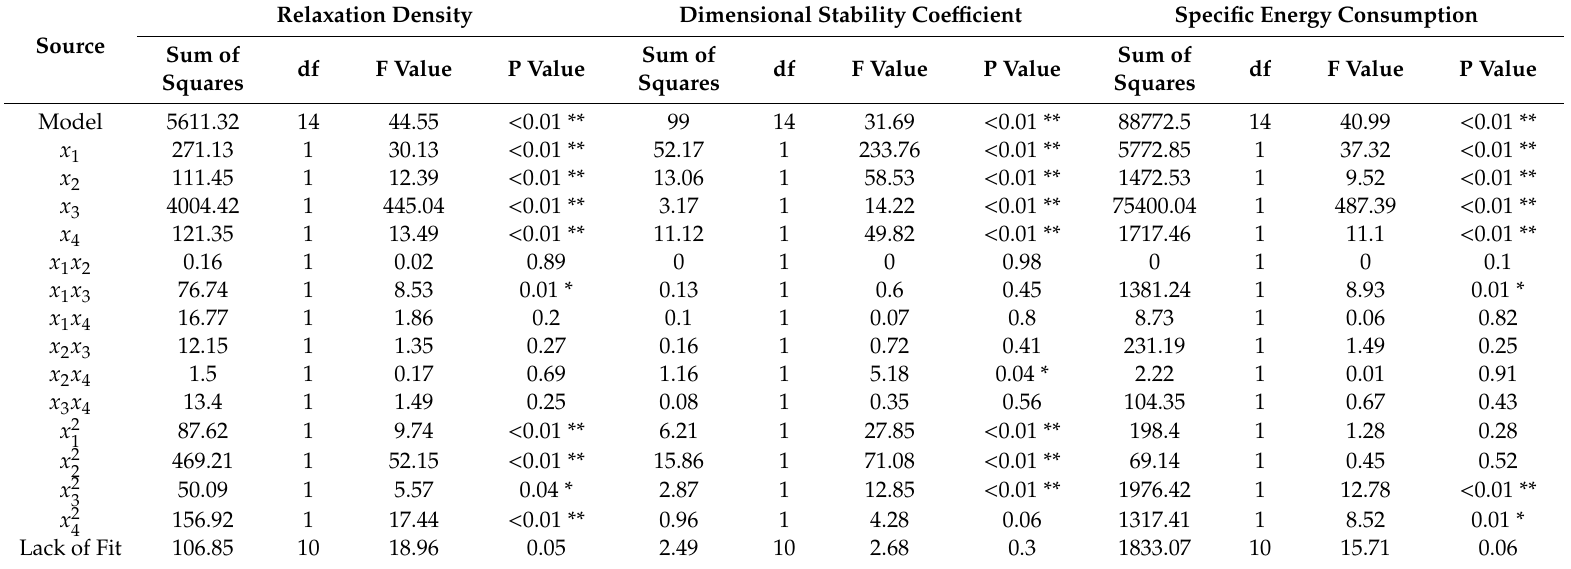
Table 6. Summary of analysis of variance (ANOVA) results for all